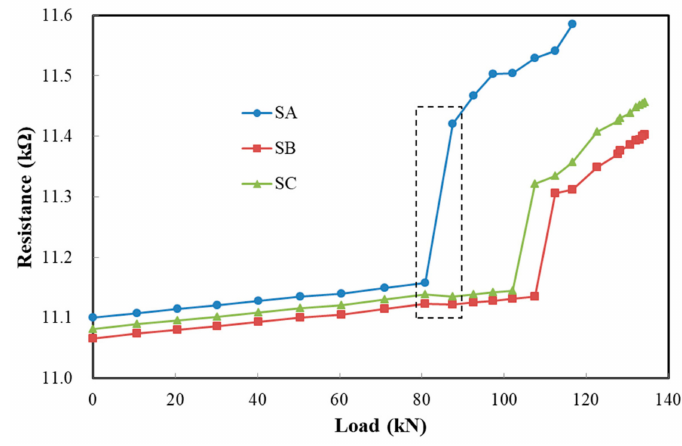
Figure 12. The resistance changes in SA, SB, and SC during